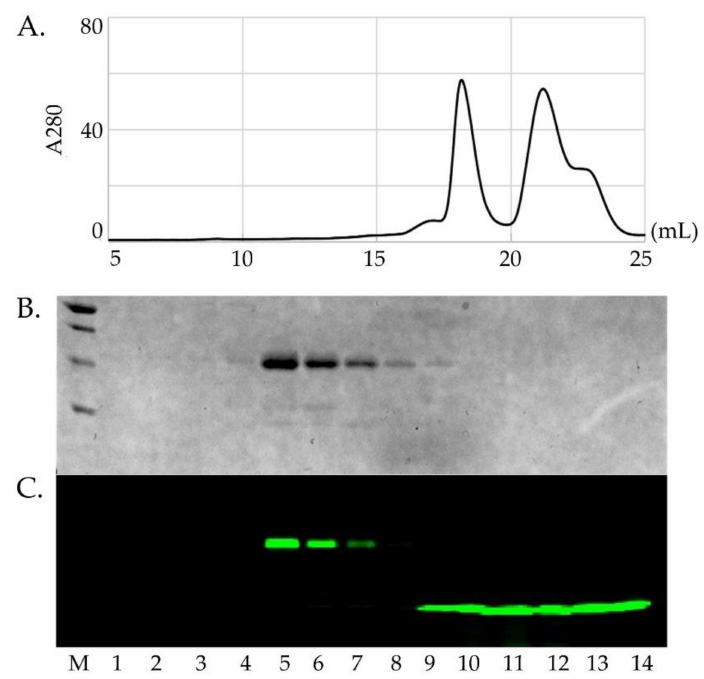
Figure 2. Fluorescent labeling and purification of Sod1. Panel ( A ) shows the purification of an Sod1 protein (left peak, 17–20 mL) after labeling with Alexa 488 from the remaining free dye (right peak, 20–24 mL). Panel ( B ) shows the SDS-PAGE gel of the peak samples imaged by Coomassie staining. Although the free Alexa 488 dye shows up in the SEC chromatogram, it does not show up in the Coomassie stained gel. Panel ( C ) shows the same gel that has been imaged using a fluoro-imager set for the emission wavelength for Alexa 488 . This shows that the Sod1 protein (lanes 4–8) has been stably conjugated with the dye and separated from the remaining free dye (lanes 9–14).